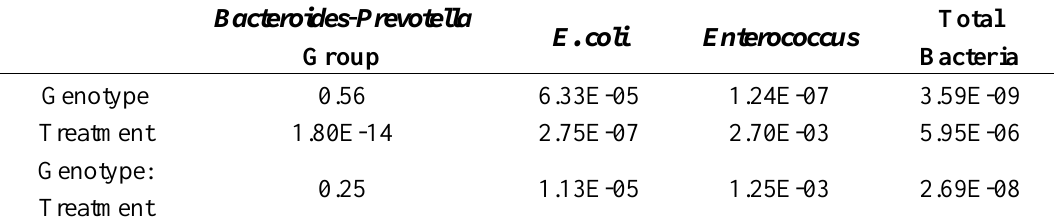
Table 1. Statistical analysis of bacterial group qPCR results. Significance values of bacterial qPCR results examining the effect of genotype, treatment, and the interaction between genotype and treatment on the number of bacteria present in the caecum (2 factor ANOVA). Bacteroides/Prevotella , E. coli , and Enterococcus were selected because of evidence for changes in these groups from either sequencing or DGGE analysis. For each target bacterial group, analysis was performed on log 10 target bacteria numbers per 10 7 total bacteria. For total bacteria, analysis was performed on log 10 total bacteria numbers per 75 ng DNA. p < 0.05 was considered statistically